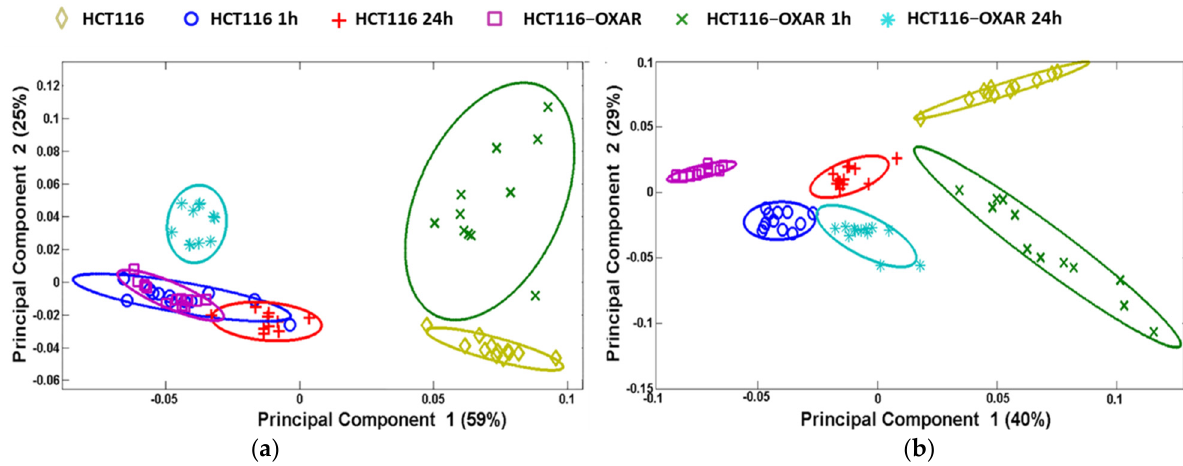
Figure 5. Principal component analysis of ToF-SIMS results demonstrating the differences between HCT116 and HCT116- OXAR cells in membrane lipid composition. The data from untreated and oxaliplatin-treated (2.0 μ M, 1 or 24 h incubation) cells were analyzed. ( a ) Scores plots on PC1 and PC2 resulting from PCA in positive ion mode. ( b ) Scores plots on PC1 and PC2 resulting from PCA in negative ion mode. A 95% confidence limit for each region was defined by an ellipse with the same color to the corresponding region clusters. Each data point represents an individual field of view. Different samples are color coded.